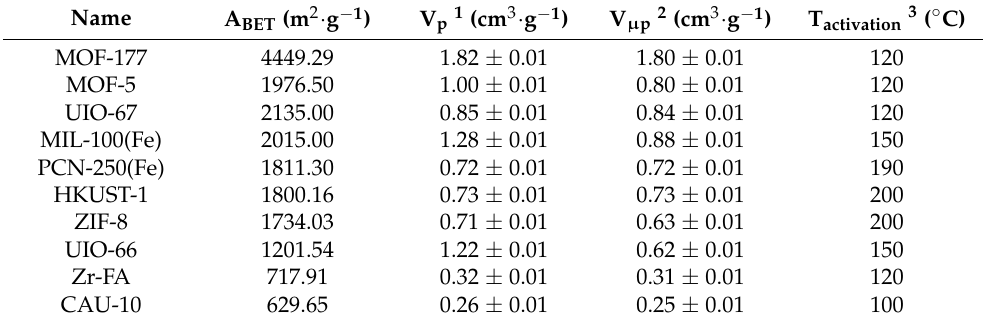
Table 1. Measured porous properties for